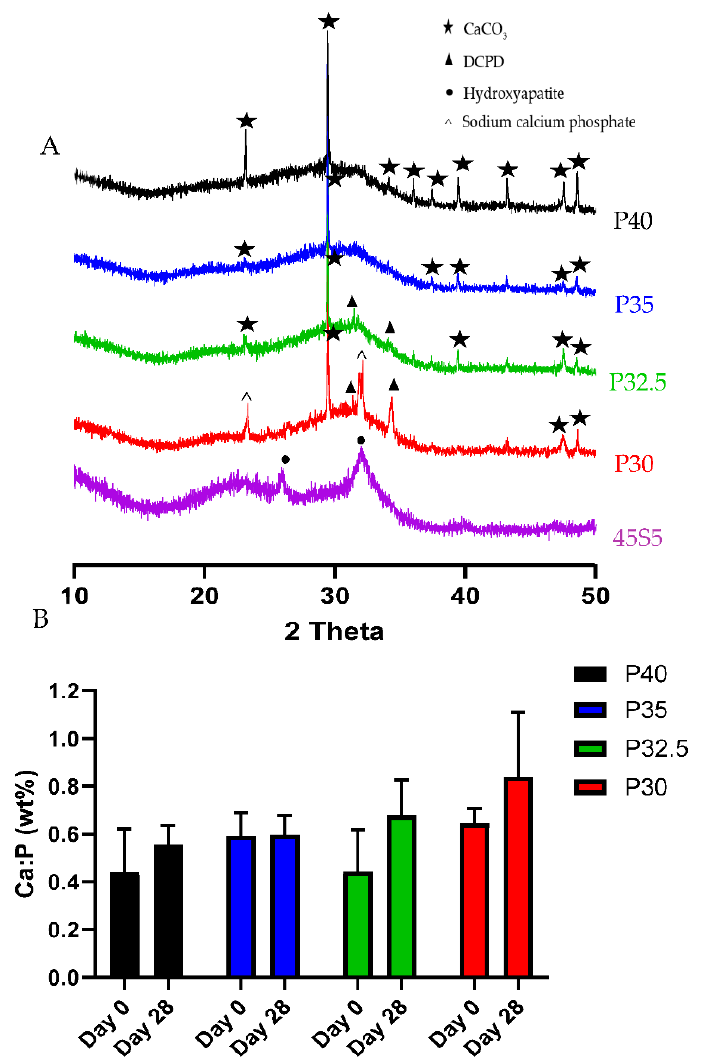
Figure 7. ( A ) Powder XRD patterns for P40 (black), P35 (blue), P32.5 (green), P30 (red) porous microspheres and 45S5 (purple) particles following 28 days of immersion in SBF. ( B ) Ca:P ratio, determined by EDX, for porous microspheres from each composition prior to SBF immersion and after 28 days of immersion.